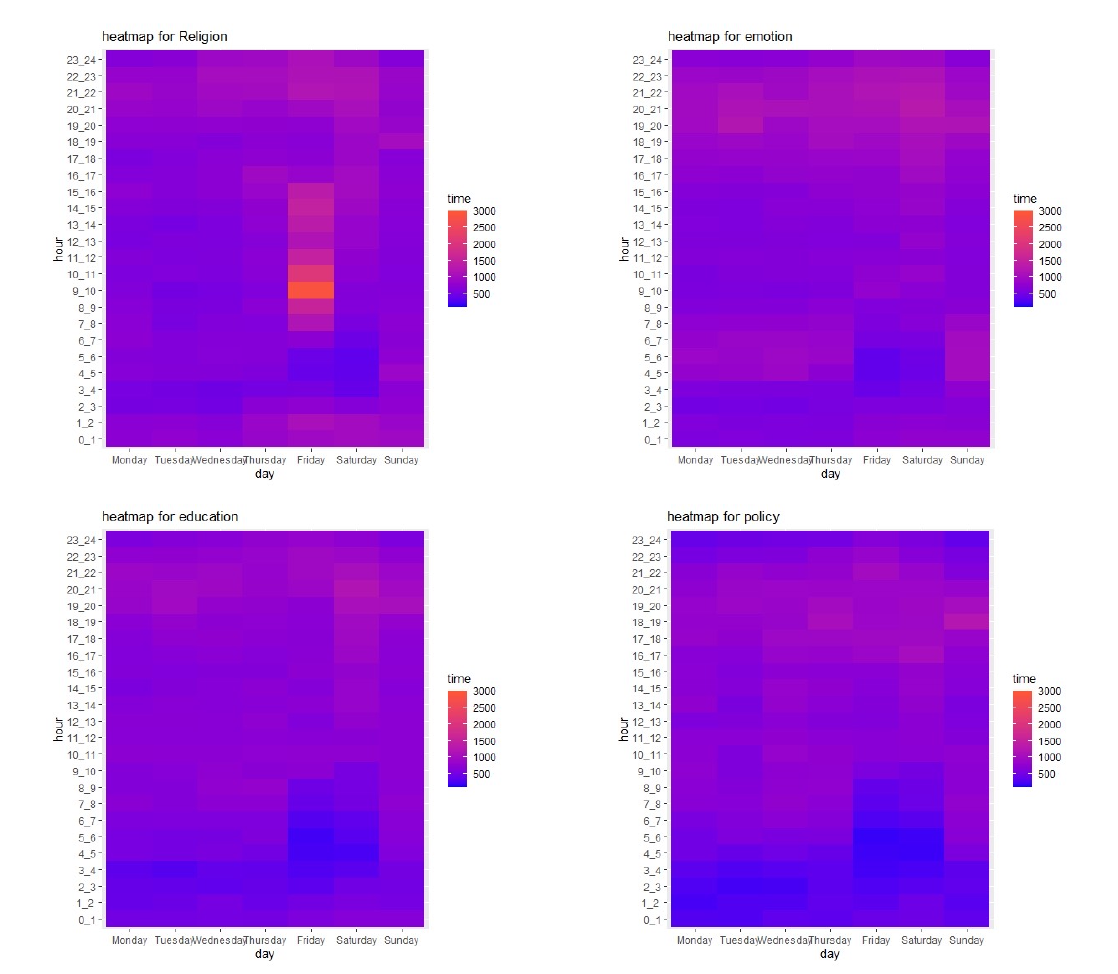
Figure 9. The number of tweets related to topics across week